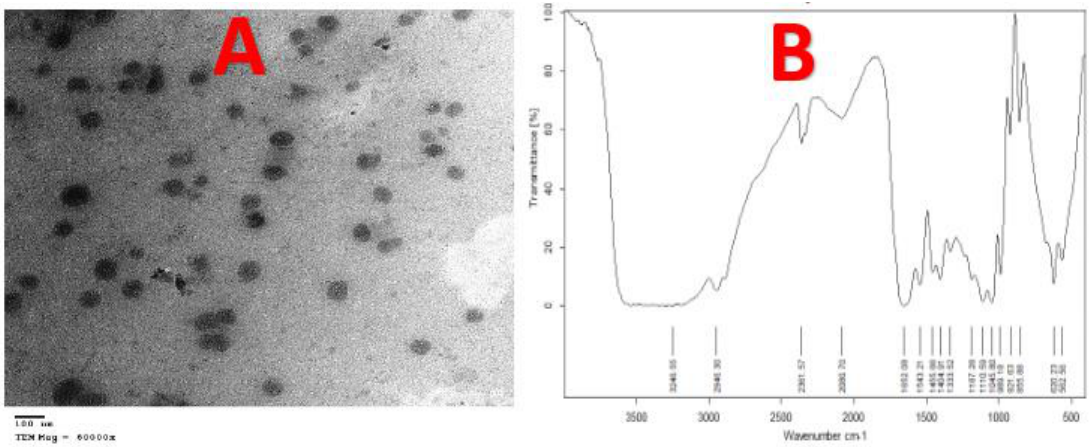
Figure 7. ( A ) TEM electron micrograph of the CuNPs. ( B ) FTIR analysis of the biotransformation CuNPs by P. fluorescens MAL2.